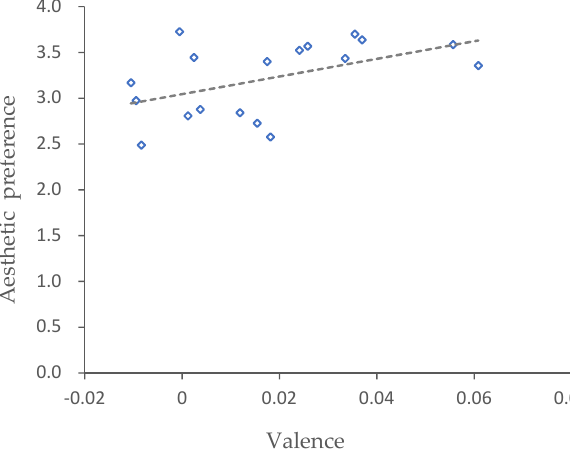
Figure 2. Correlation between aesthetic preference and emotional perception.